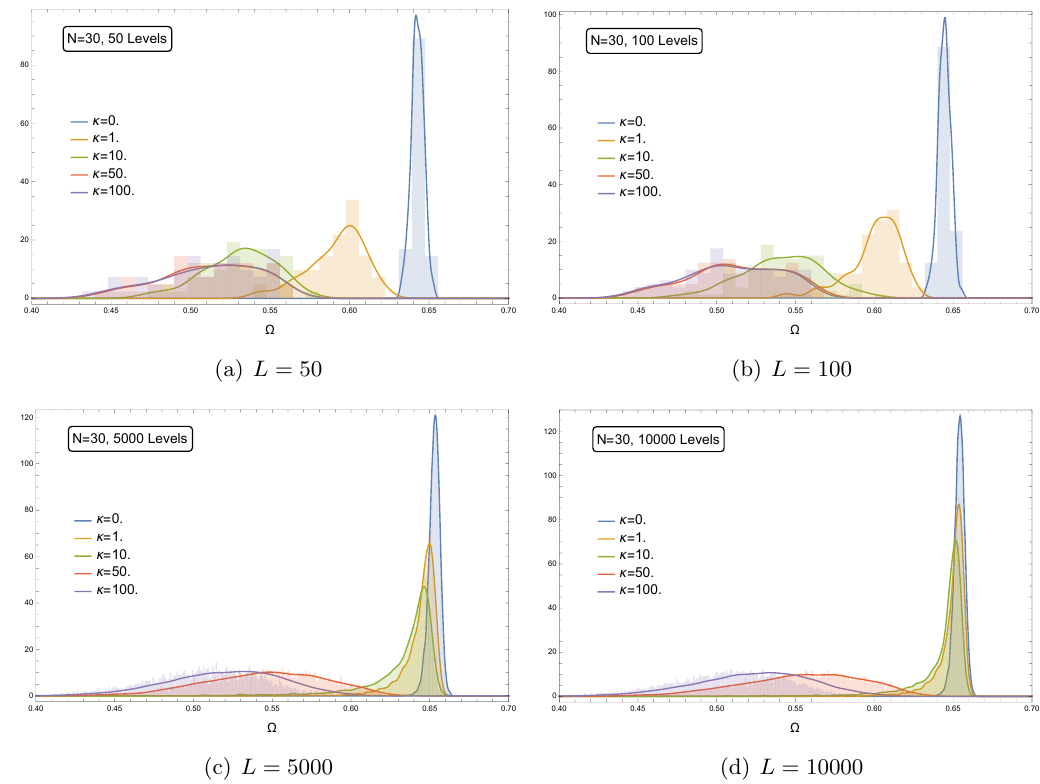
Figure 13 . The distribution of the IR diversity of the subsectors of the spectra including L levels starting from the ground state of the even parity sector ( D = 2 14 ) of N = 30 SYK model with (cid:20) = 0 ; 1 ; 10 ; 50 ; 100 ( L = 50 ; 100 ; 5000 ; 10000).